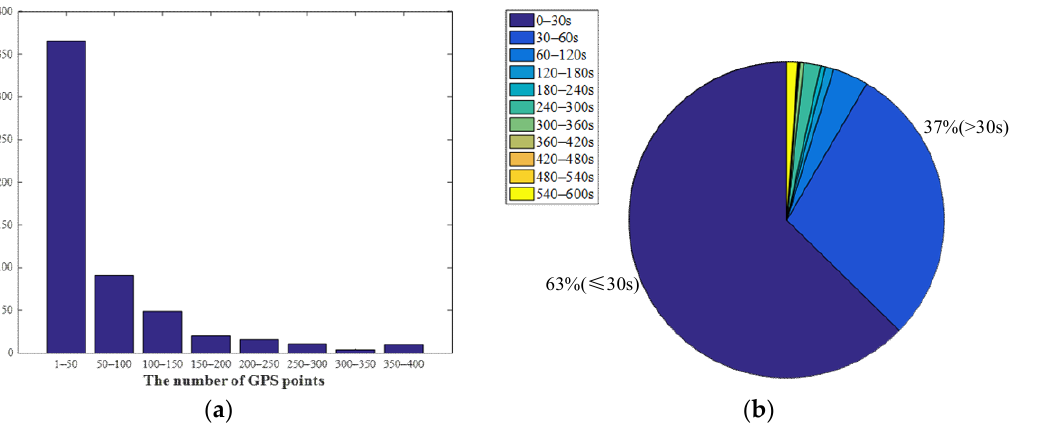
Figure 10. Description of the trajectory dataset: ( a ) number of GPS points of trajectories; ( b ) sam- pling rate of GPS points. rate of GPS